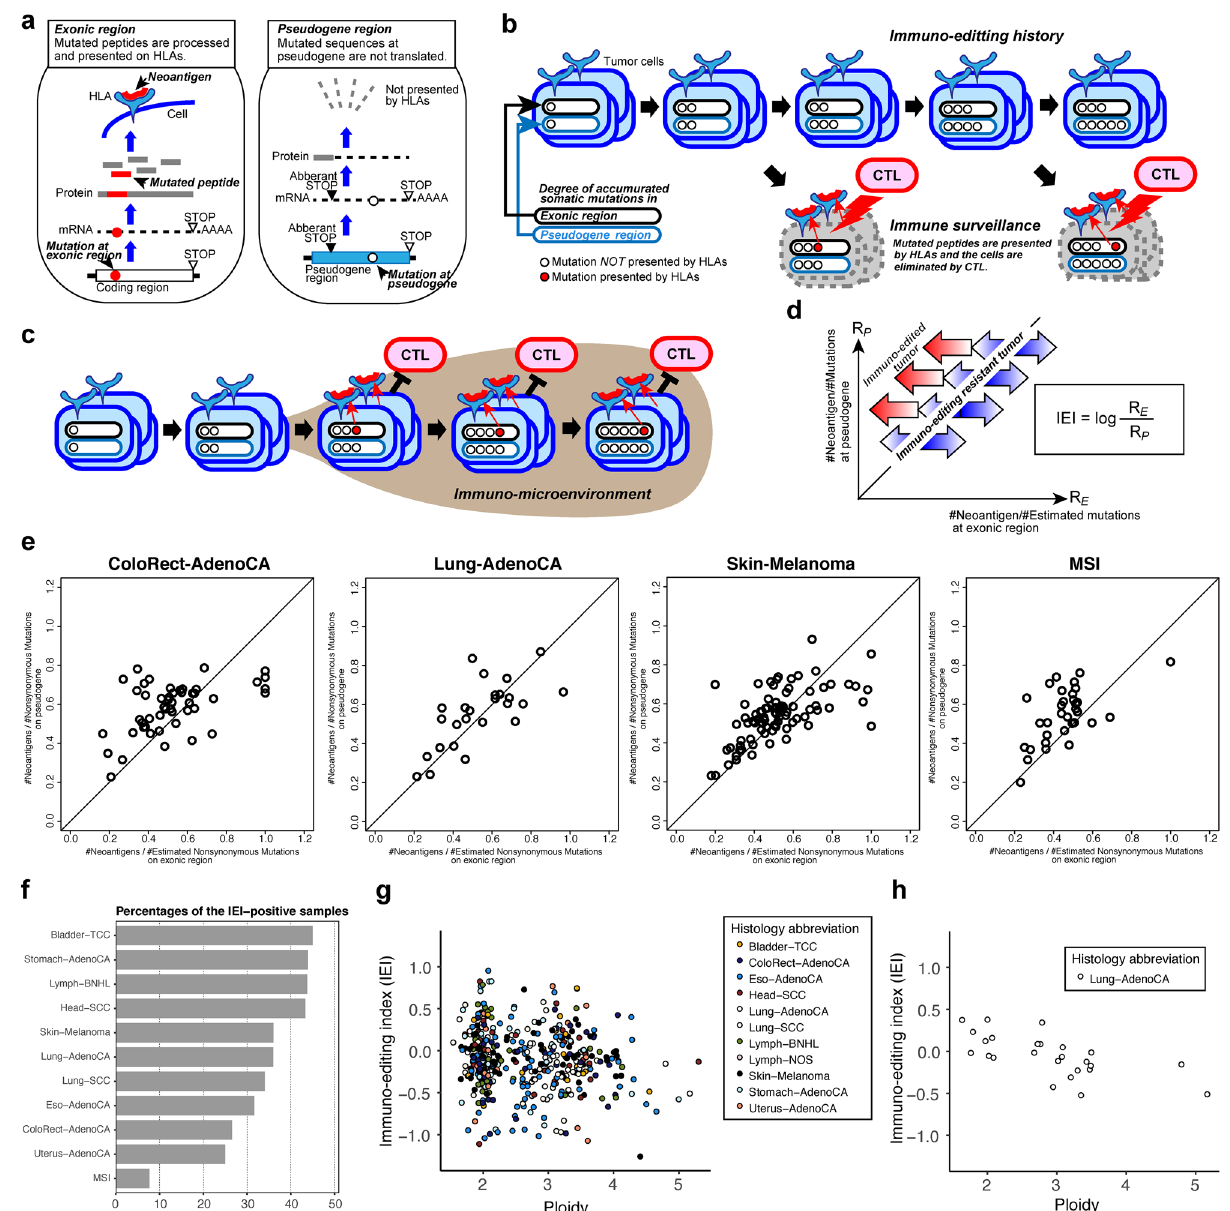
Figure 2. Analysis of immunoediting history. ( a ) An overview of the presentation of neoantigens (NAGs) generated from nonsynonymous mutations in exonic regions. Pseudogene regions are not translated, and mutations that accumulate in pseudogenes are not presented by the HLA complex. ( b ) Relationship between accumulated mutations in exonic regions and pseudogenes in the immunoediting history. Although cytotoxic T-cells eliminate tumor cells by recognizing these NAGs, some tumor cells escape this immune surveillance mechanism and eventually contribute to the formation of a clinical tumor. ( c ) In immunoediting-resistant tumors, the tumor cells immediately escaped from immune pressure in the carcinogenic process, and the difference between NAGs in exonic and pseudogene regions was expected to be small. ( d ) Immunopressure plot of NAGs in exonic regions and pseudogenes. The x -axis represents the pseudo-antigen ratio R P for mutations in pseudogene regions, and the y -axis shows the neoantigen ratio R E for mutations in exonic regions. Immunoediting index (IEI) was defined as the log ratio of R P to R E and was used to characterize the immunoediting history of each donor, with immunoedited and immunoediting-resistant tumors. ( e ) Immunopressure plots of four cancer types. Microsatellite instability-positive tumors show the most immunoedited tumor characteristics; in other cancers, many tumors showed an immunoediting-resistant tendency. ( f ) The proportion of immunoediting-resistant tumors. ( g , h ) Tumor ploidy and IEI for a pan-cancer analysis ( g ; n = 433) and lung adenocarcinoma ( h ; n = 25). Each dot represents a tumor